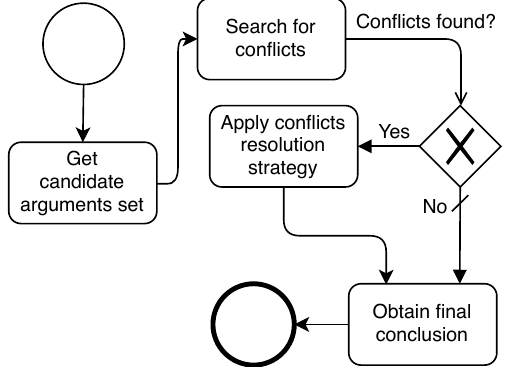
Figure 5. Conclusion